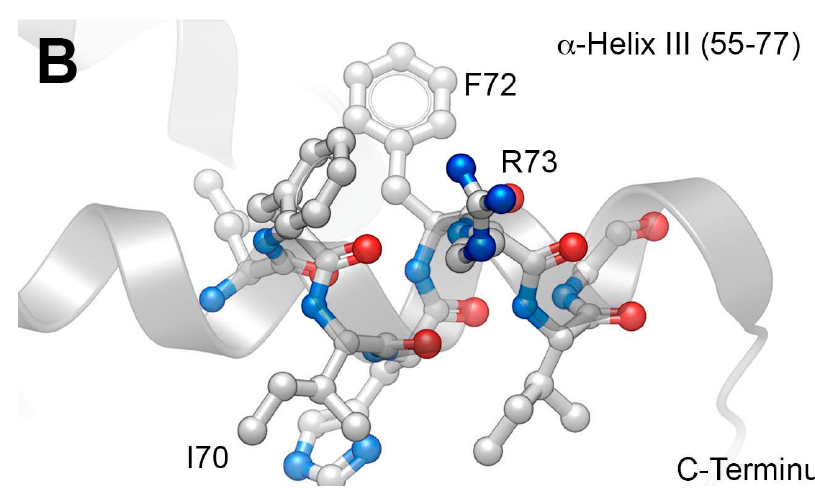
Figure 1. NMR solution structure of Vpr (1–96) (PDB accession code: 1M8L [19]). ( A ) Full-length structure showing helices; ( B ) Closeup of α -helix III showing residues “FIHFRIG” (69–75) overlain on a ribbon depiction.